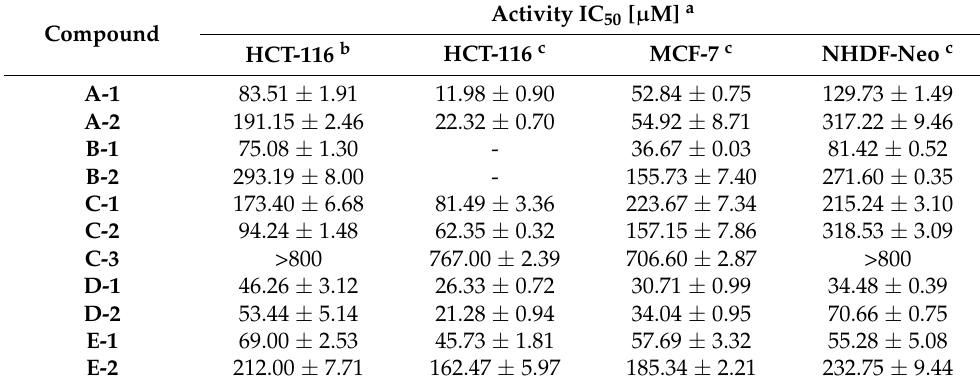
Table 2. Cytotoxicity of quinoline glycoconjugates evaluated by the MTT